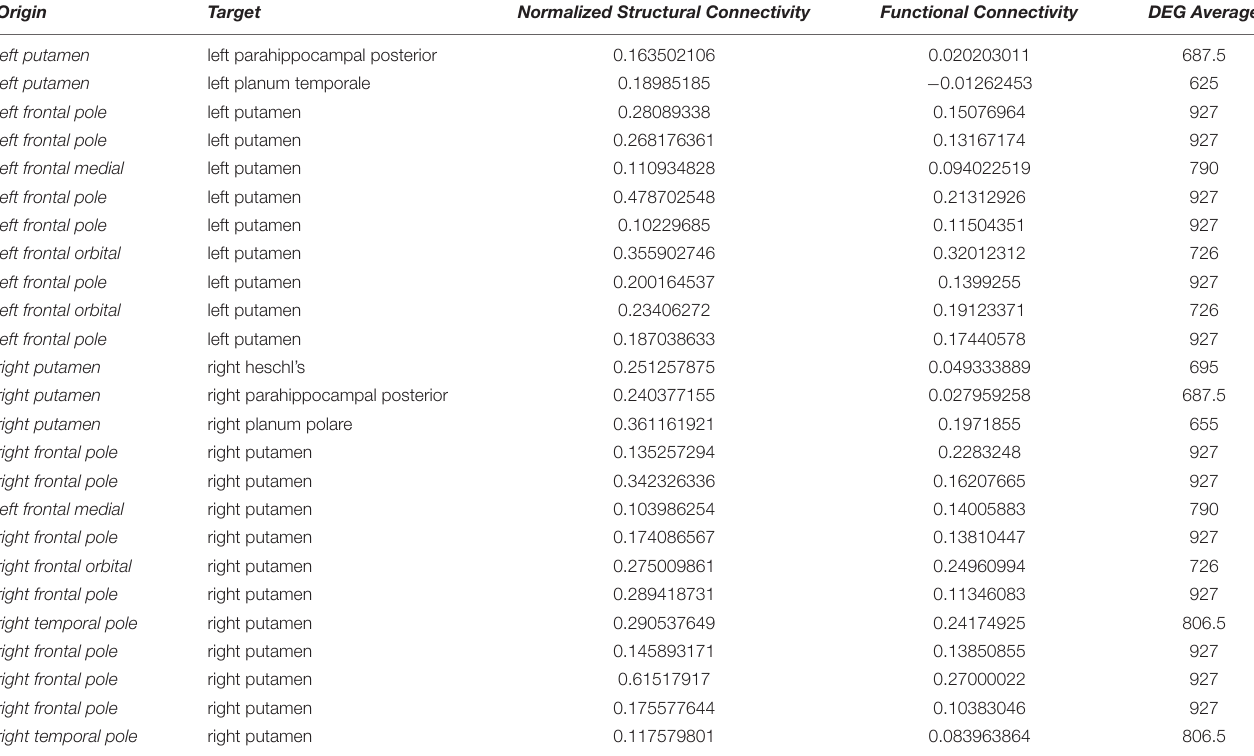
TABLE 1 | Highly differentially expressed genes (DEG) between the putamen and structurally connected brain areas.